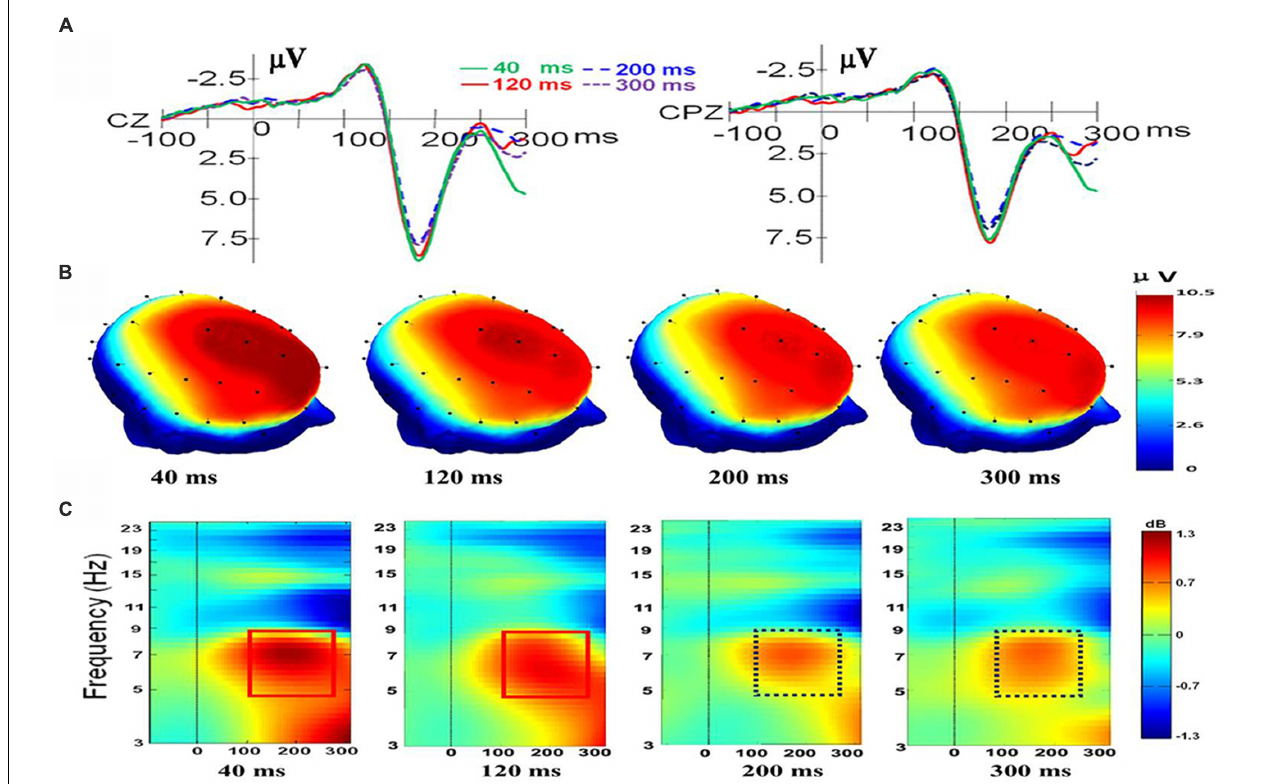
FIGURE 1 | The electroencephalogram (EEG)/event-related potentials (ERPs) results at the Cz and CPz electrode sites. (A) The grand-averaged ERPs waveforms (N170/VPP) elicited by a fleeting facial expression with a duration of 40 (green solid), 120 (red solid), 200 (blue dashed), and 300 ms (purple dashed) at the Cz and CPz electrode sites. (B) Scalp potential 3D maps reveal the topography of the N170/VPP for the time window (140–200 ms). (C) Event-Related Spectral Perturbation (ERSP) plot showing the mean increases or decreases in spectral power following stimulation. Non-green areas in the time/frequency plane show significant ( p < 0.01) post-stimulus increases or decreases (see color scale) in log spectral power at the CPz electrode site relative to the mean power in the averaged 1-s pre-stimulus baseline (the interval for the ERSP analysis was − 1000–1500